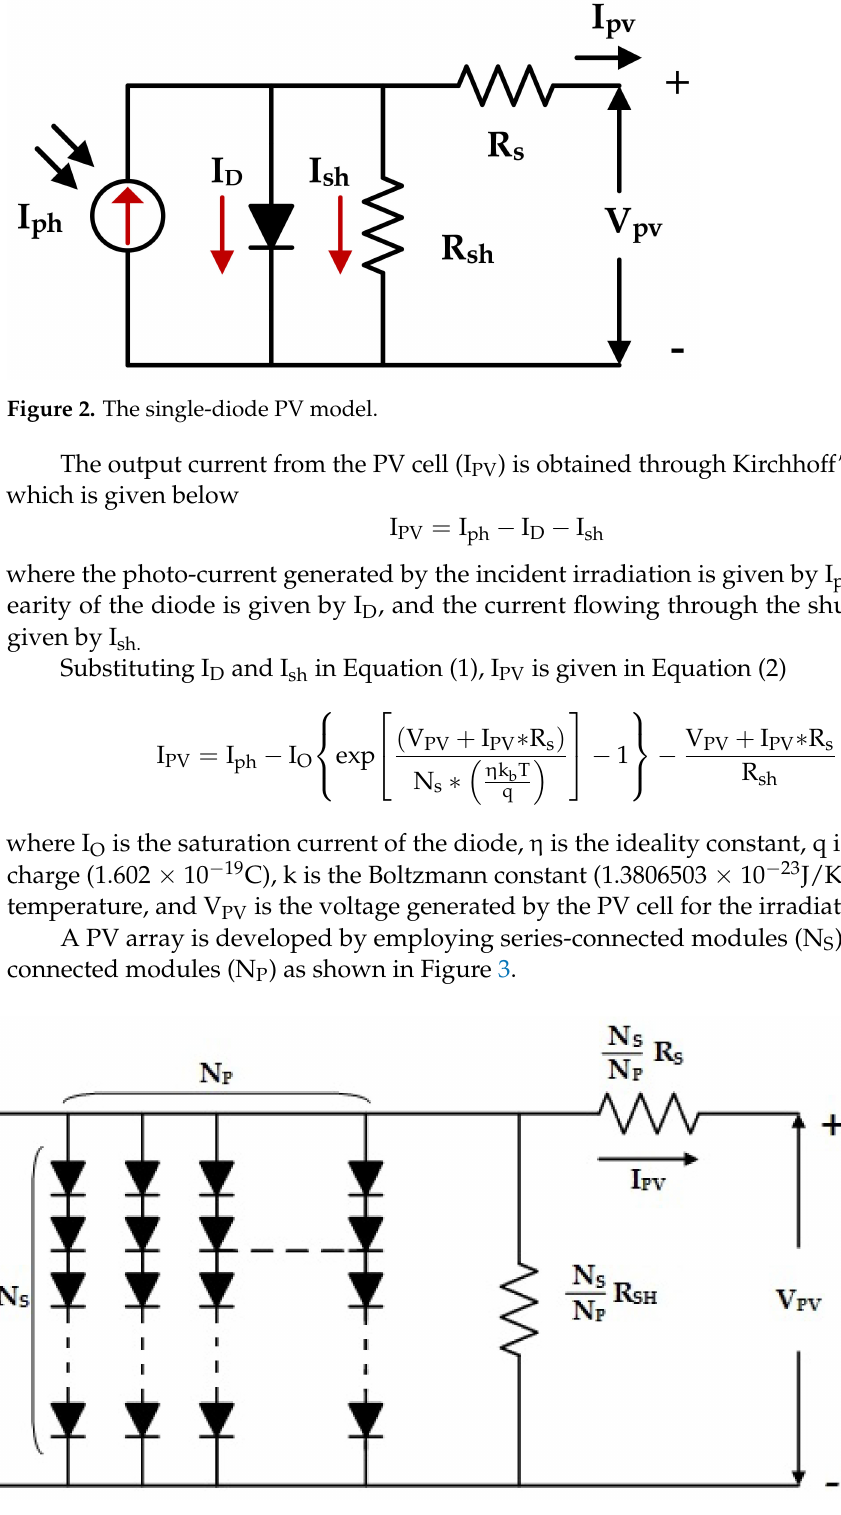
Figure 3. Equivalent circuit of a PV